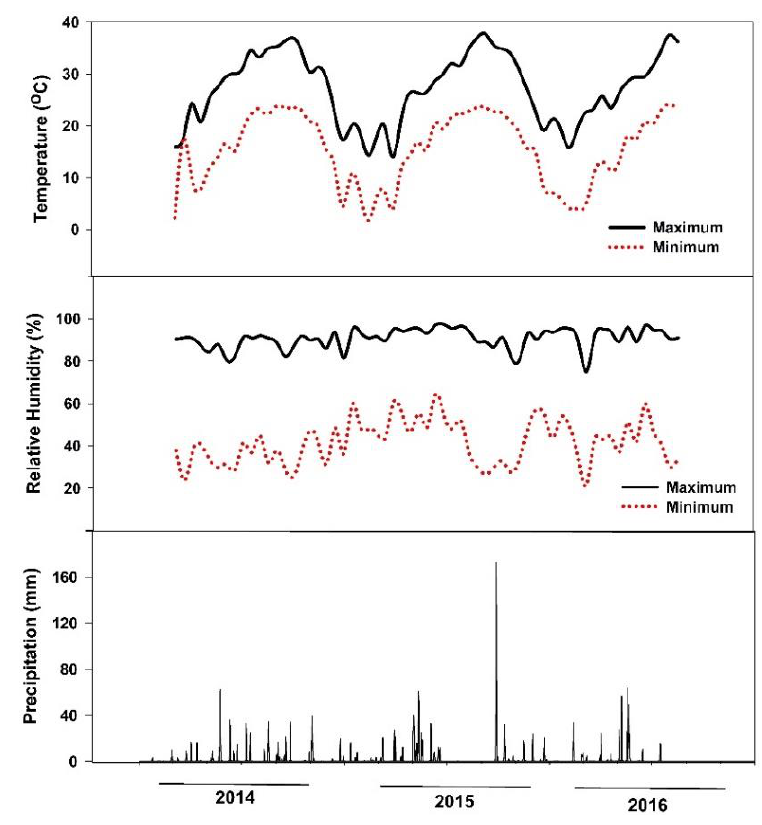
Figure 5. Maximum and minimum air temperature, air relative humidity, and precipitation of the study site at Uvalde, Texas, during the experimental period (October 2014–August 2016).